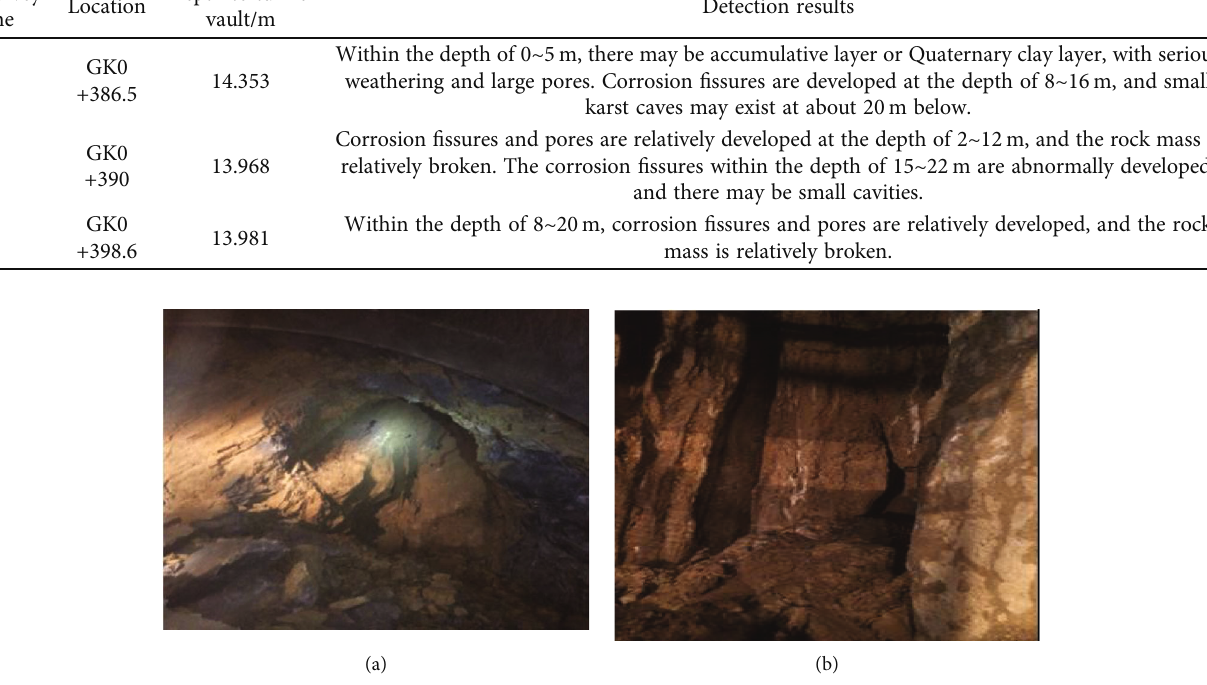
Figure 6: Pictures of the revealed karst caves: (a) GK0+400; (b) GK0+405.